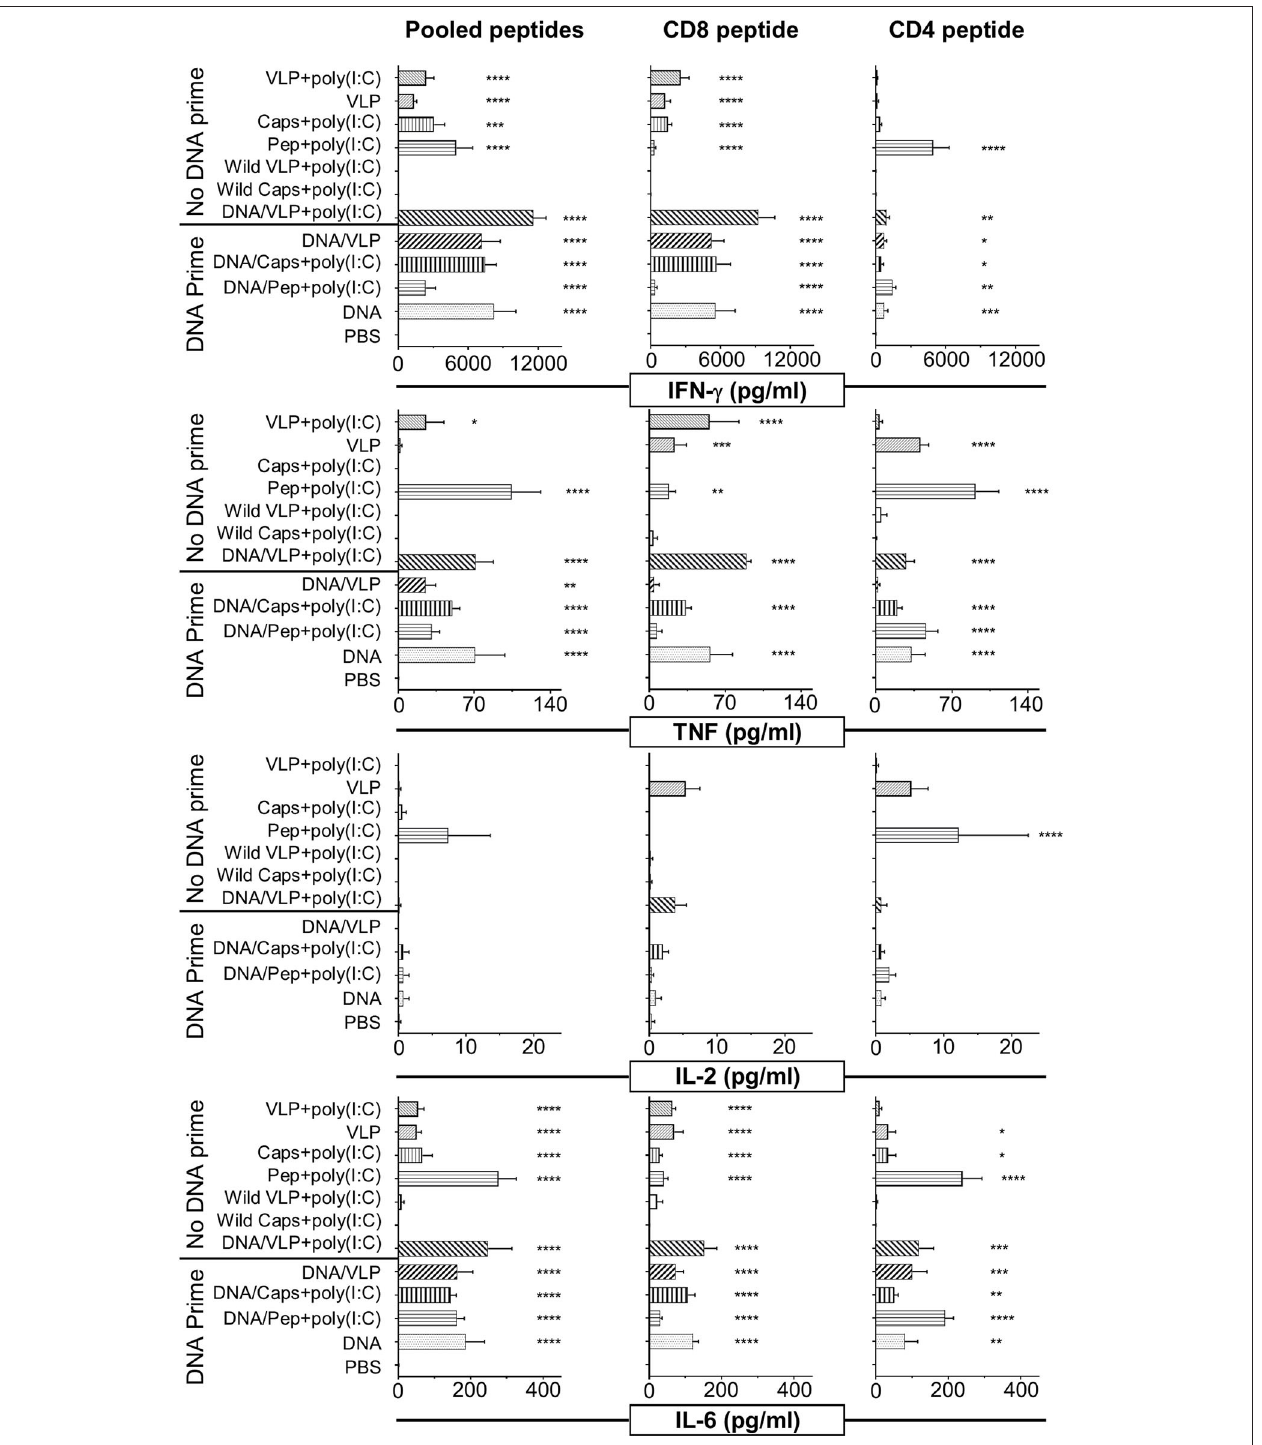
FIGURE 2 | Cytometric bead array analysis of antigen-specific cytokine responses induced by immunization with chimeric VLPs or capsomeres. BALB/c mice ( n = 5/group) were immunized with either a homologous (no DNA prime) or heterologous (DNA prime-boost) regimen as described in the legend to Figure 1 . Seven days after the third immunization splenocytes were harvested and single cell suspensions stimulated with either the CD8 + (280 − 288) , or CD4 + (58 − 79) T cell peptides or with pooled peptides including both peptides plus the B cell repeat peptide and incubated for 72h at 37 ◦ C and 5% CO 2 . Culture supernatant was assayed using a cytometric bead array to quantify IFN- γ , TNF, IL-2, and IL-6 cytokine levels. Data are displayed as mean pg/ml + SEM for each cytokine with statistical comparisons made to the PBS control group with significance determined using one-way ANOVA followed by Bonferroni’s post-test. * p < 0.05, ** p < 0.01, *** p < 0.001, and **** p <